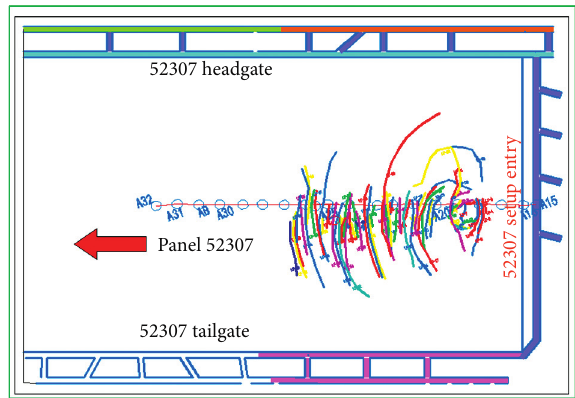
Figure 11: Contrast map for surface cracks in working face 52307 and observation